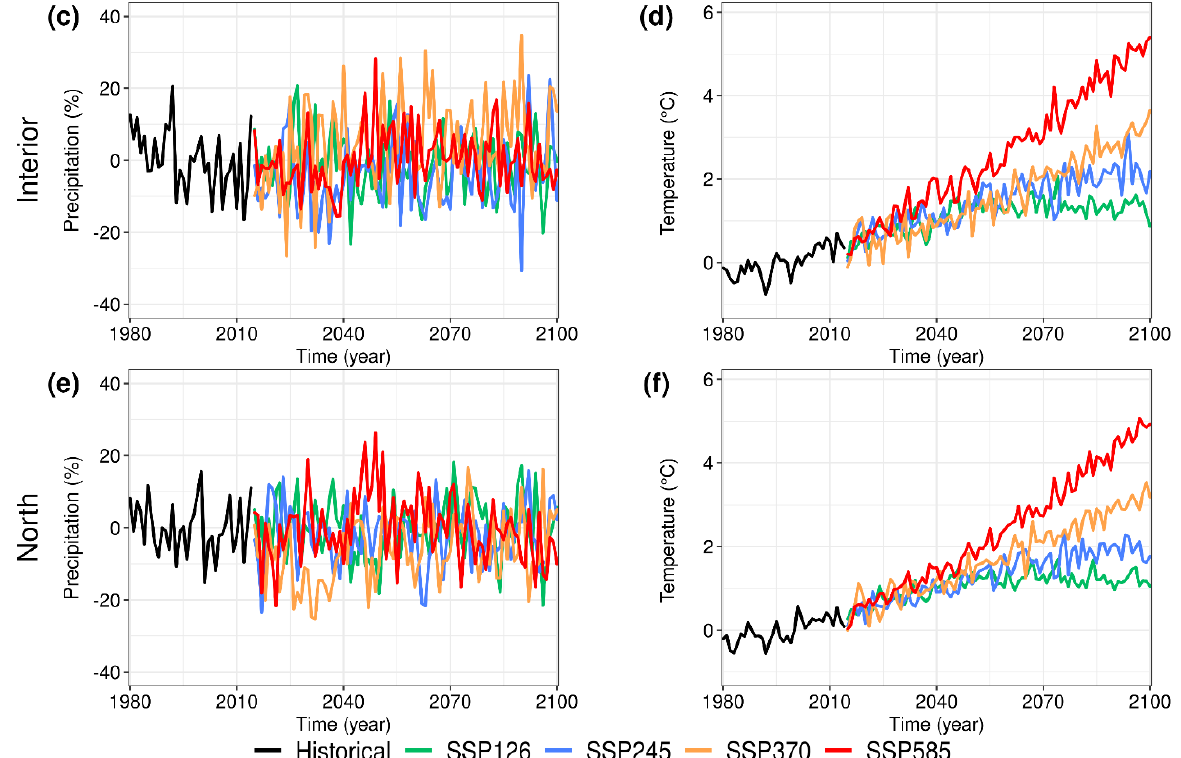
Figure 11. Projections of total annual precipitation anomalies (%) and air temperature near the surface (°C) on NEB relative to the reference period (1980–2014): ( a , b ) East Coast, ( c , d ) Interior, and ( e , f ) North. The colored lines correspond to the average of the 5 best models (ensemble) of CMIP6 for the SSP1-2.6, SSP2-4.5, SSP3-7.0, and SSP5-8.5 scenarios.